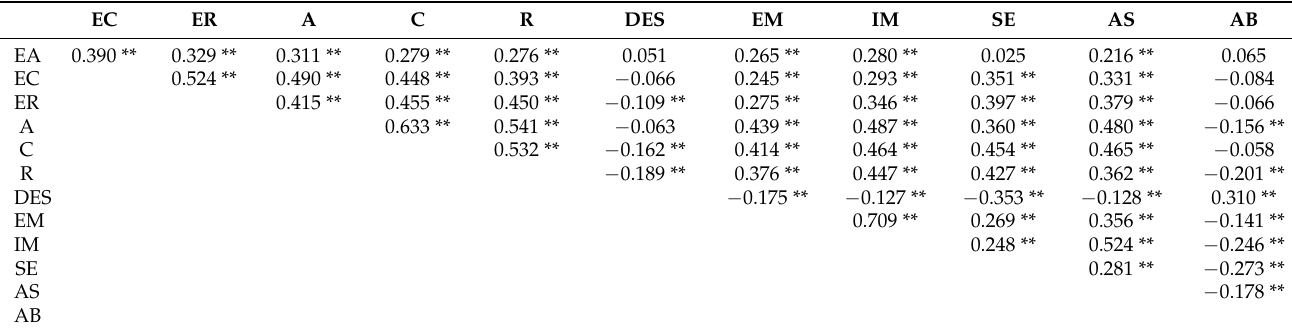
Table 4. Correlation between the dimensions of the